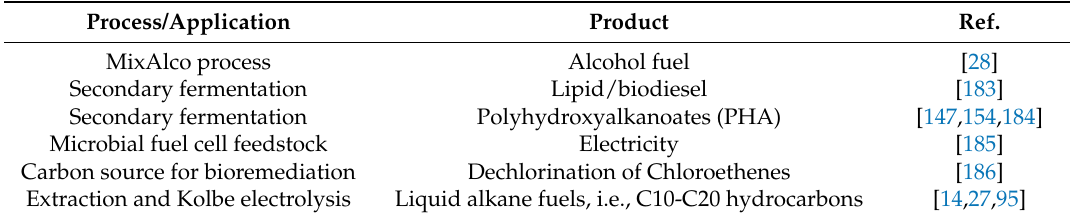
Table 7. Processes and applications for carboxylic acid-rich (MCCAs and VFAs) fermentation effluent currently described in